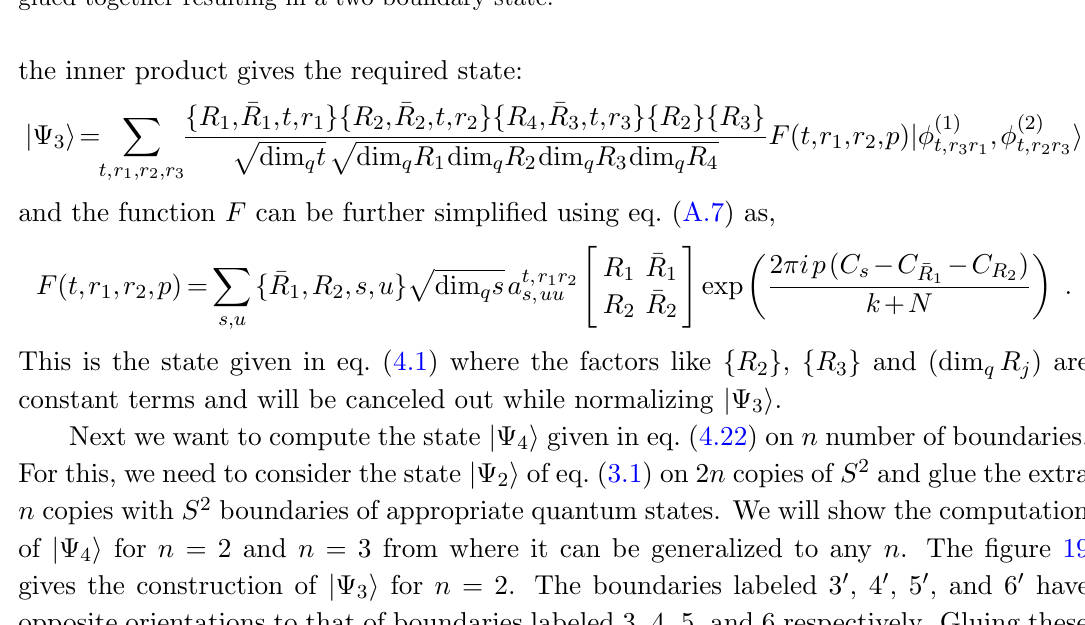
Figure 19 . Figure showing how to construct the state j (cid:31) are oppositely oriented compared to the boundaries labeled j (where j = 3 , 4 , 5 , 6) and can be glued together resulting in a two boundary